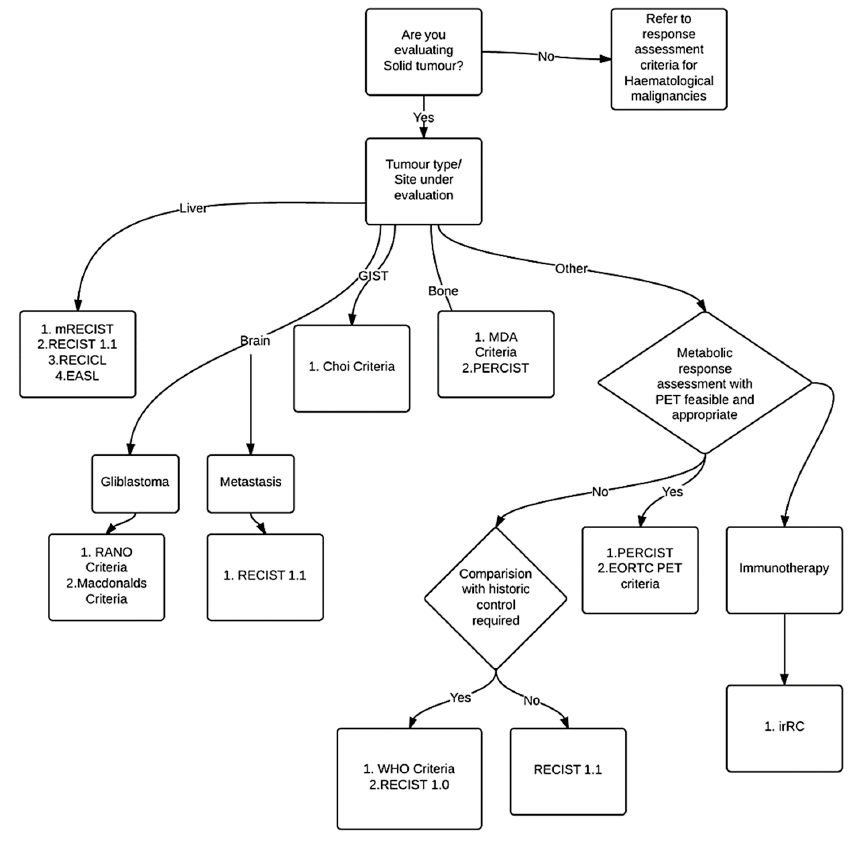
Figure 1. Decision algorithm for choosing response criteria.